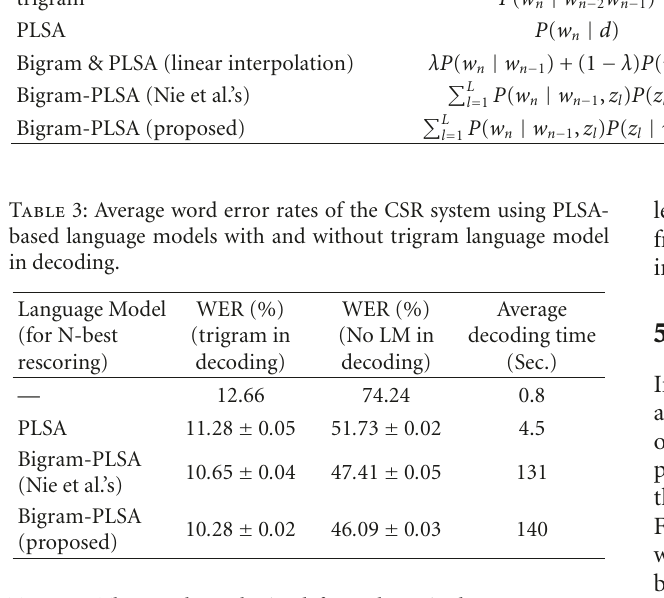
Table 4: The P -values obtained from the paired t -test on WER results of Nie et al.’s and proposed method. LM in decoding P -value Trigram 6 . 53 E − 10 No LM 1 . 70 E −